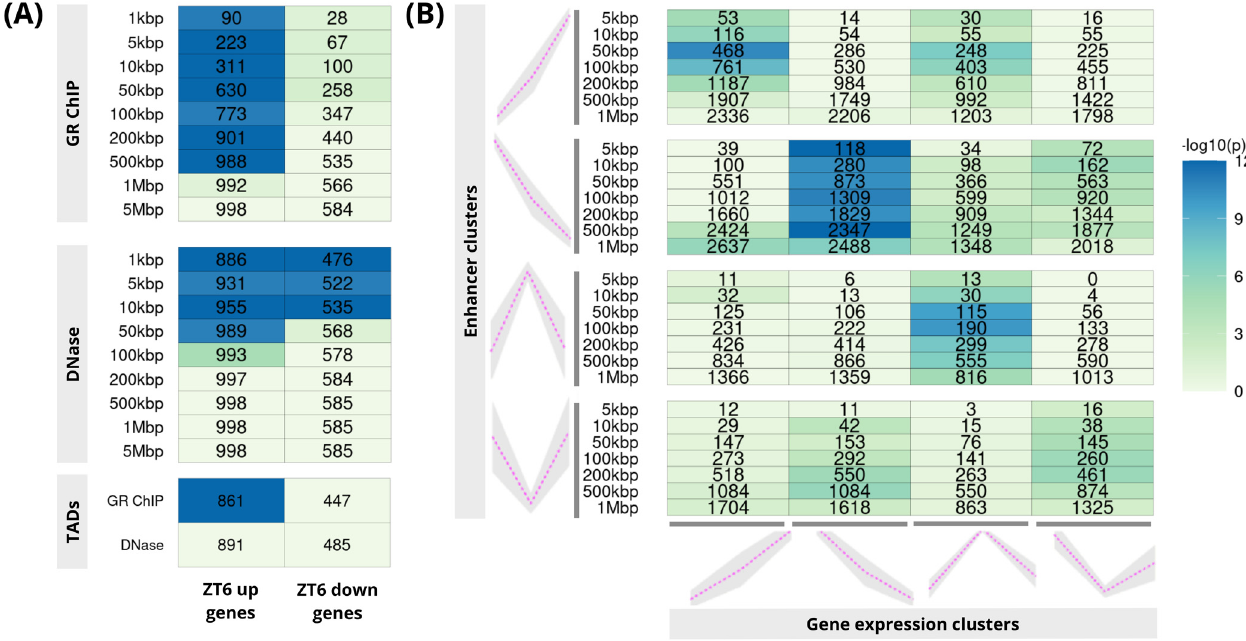
Figure 2. PEGS applications: ( A ) gene expression, ChIP-seq and DNase I data on mouse liver; upper two panels correspond to GR ChIP-seq and DNase peaks expanded to different genomic distances while the bottom panel shows both GR ChIP-seq and DNase peaks expanded to overlapping TAD boundaries ( B ) gene clusters derived from scRNA-seq and intergenic putative enhancer clusters from bulk ATAC-seq from three matching early stem cell differentiation time-points. In both plots, numbers in the cells show common genes among the input genes (x-axis) and genes overlapping with expanded peaks (y-axis) and the colour shows − log of p-value (Hypergeometric 10